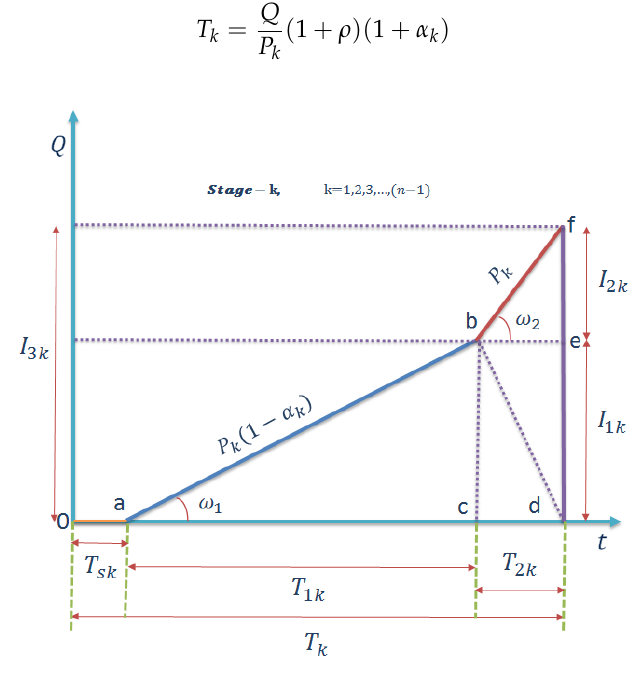
th production stage.